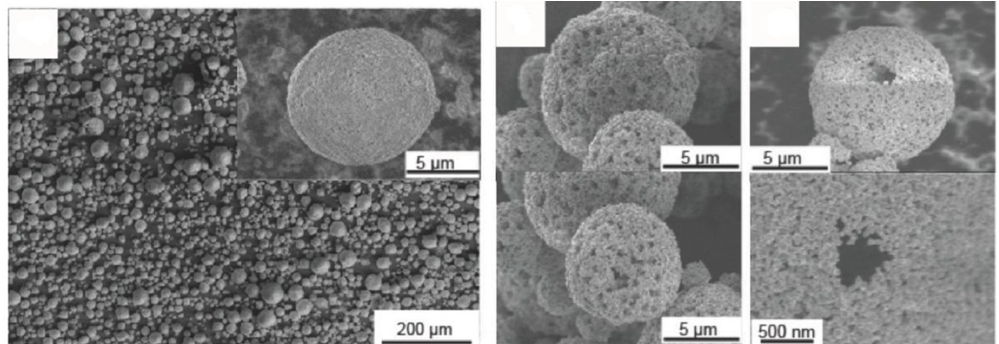
Figure 8. Li 4 Ti 5 O 12 spray-dried granules after heat treatment in air to decompose the organic templates: ( left ) nanoporous microspheres obtained from spray-drying with 3 wt % cellulose; ( middle ) macroporous spheres obtained from spray-drying with polystyrene beads as template and ( right ) microspheres with channel structures obtained from spray-drying with carbon fiber templates. (Reproduced from [234] under CC BY 4.0—https://creativecommons.org/licenses/by/4.0/).